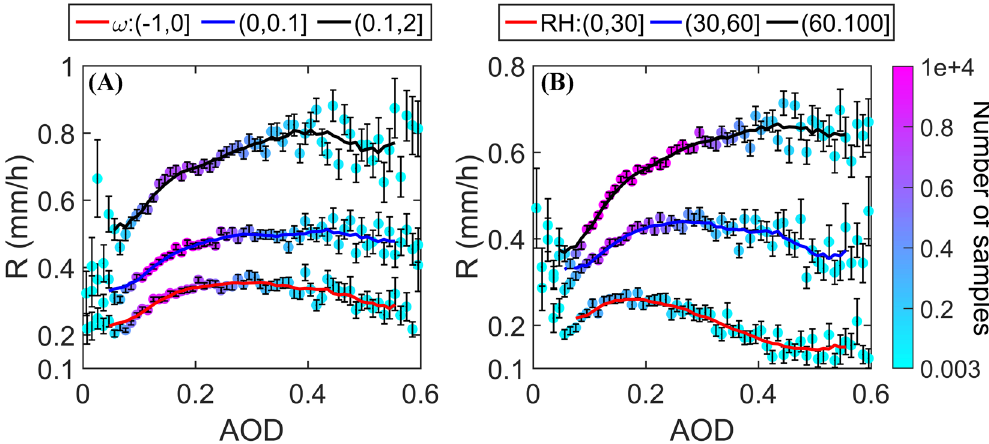
Figure 3. R as a function of AOD (bin size of 0.01) for specific meteorological conditions over the ROI at 1330 local time in JJA (2003–2012). ( A ) For ω 400 ranges; ( B ) for RH 500 ranges. The colors show the number of samples per bin, the error bars represent standard errors, and the red, blue and black lines represent their corresponding 9-point moving average curves.